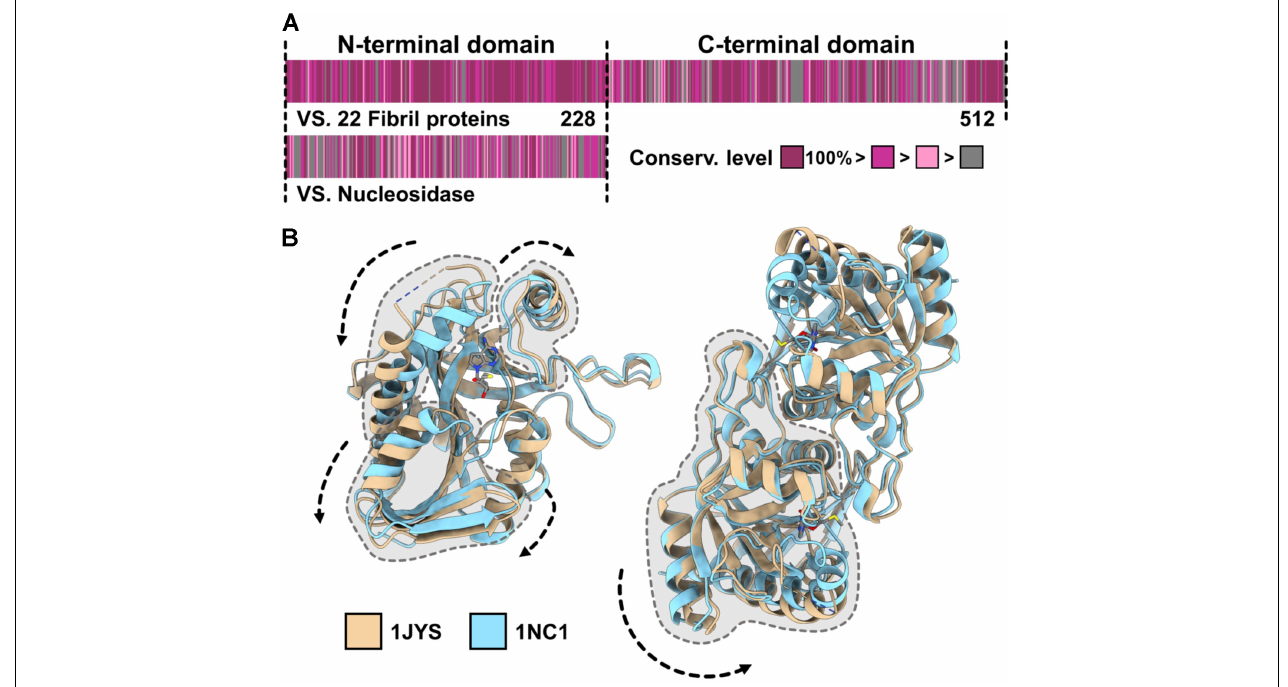
FIGURE 5 | Evolutional origin of the fibril protein. (A) Amino acid sequence of the Spiroplasma eriocheiris fibril protein. The fibril protein, composed of 512 amino acids, can be divided into the N-terminal domain including 1–228 amino acids, which has homology to bacterial S-adenosylhomocysteine (SAH) nucleosidase, and the remaining fibril-specific C-terminal domain. The conservation level of the amino acid sequence among the fibril proteins from 23 Spiroplasma species (upper) and that against SAH nucleosidase from Bacillus anthracis (WP_098760943.1) are colored from gray (low) to purple (high) based on the Gonnet PAM 250 matrix (Larkin et al., 2007; Floden et al., 2016). (B) Conformational changes in the SAH nucleosidase. The two structures of SAH nucleosidase from Escherichia coli (PDB ID: 1JYS, 1NC1) are superposed. The conformational changes intra- (left) and inter-subunit (right) are indicated by dashed